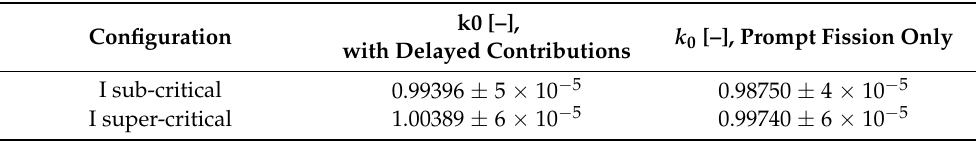
Table 4. Fundamental eigenvalues k 0 for Problem